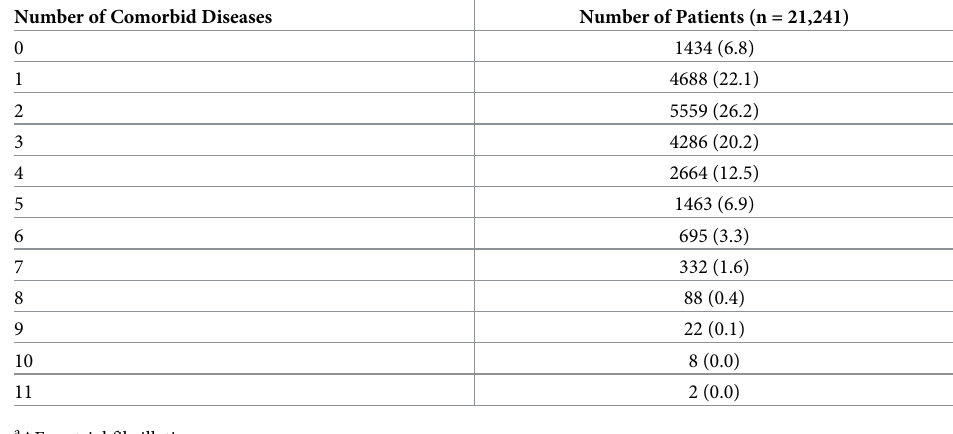
Table 1. Proportion of AF patients according to number of comorbid diseases a